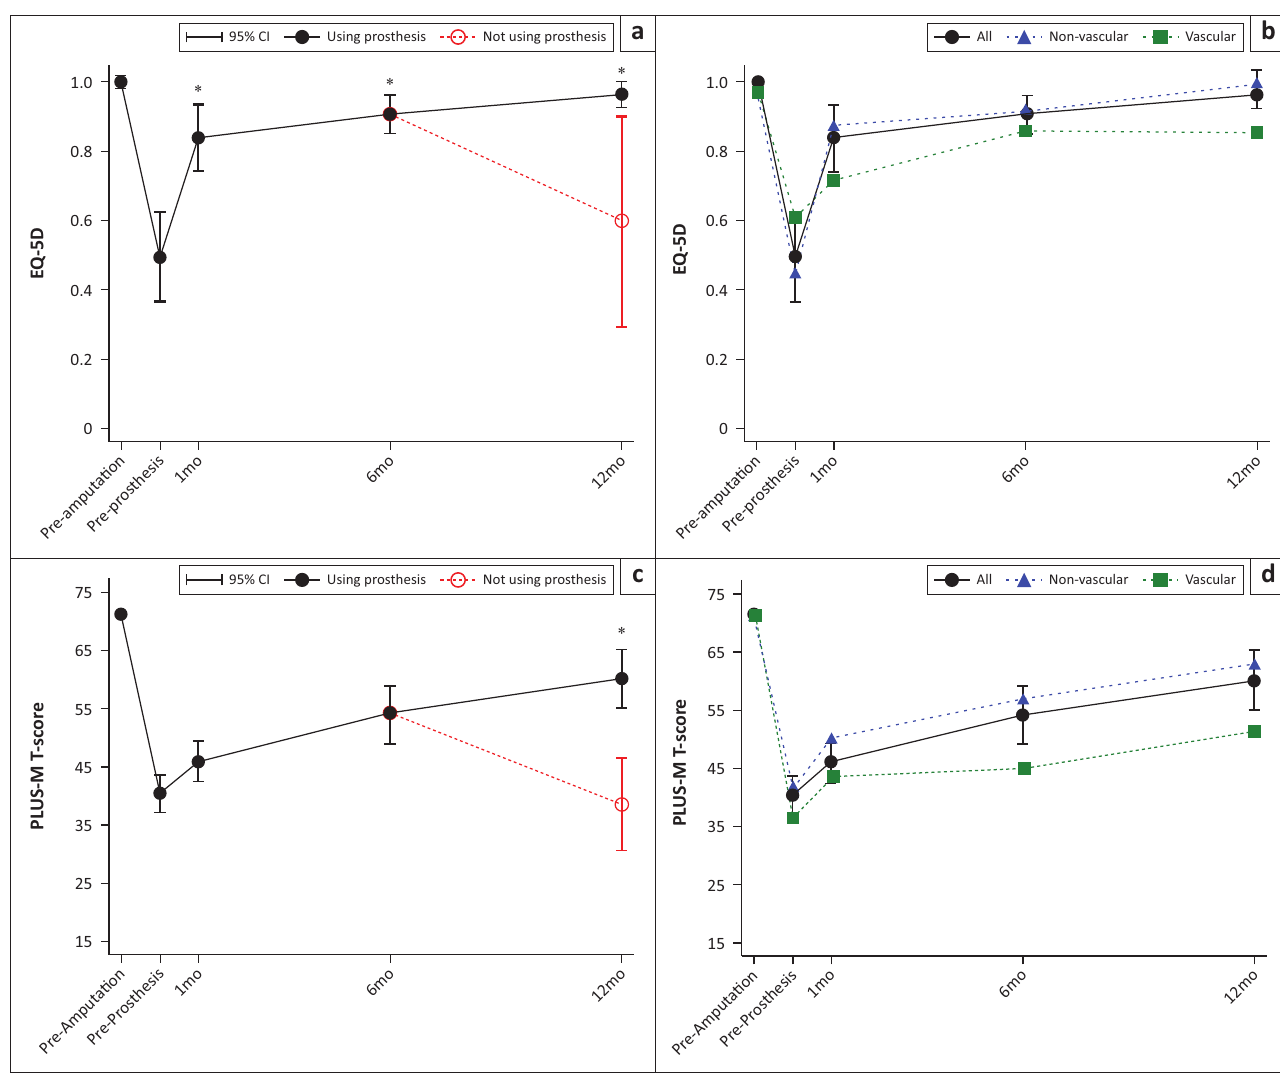
Note: Patient-reported outcome scores for patients reported to be using their prosthesis are shown in black, for patients reported not to be using their prosthesis are shown in red, for patients who underwent transfemoral amputation for trauma, tumour or infection are shown in blue and for patients who underwent transfemoral amputation for diabetes or vascular disease are shown in green. 95% confidence intervals (95 % CI) are reported. p -values were calculated using one-way repeated measures ANOVA and post hoc pairwise comparison with Bonferroni correction between pre-prosthesis and each subsequent follow-up timepoint, *, p < 0.05. FIGURE 3 : Patient-reported outcomes before amputation, at the casting visit before prosthesis fitting, 1, 6 and 12 months after prosthesis fitting: (a) EuroQol-5D (EQ-5D) health status scores before amputation (pre-amputation), at the casting visit before prosthesis fitting (pre-prosthesis) and at 1 month (1 mo), 6 months (6 mo) and 12 months (12 mo) follow-up after prosthesis fitting; (b) EQ-5D health status scores for patients separated by the reason for amputation at pre-amputation, pre-prosthesis, 1 mo, 6 mo and 12 mo for patients reported to be using their prosthesis; (c) Prosthetic Limb Users Survey of Mobility (PLUS-M) scores at pre-amputation, pre-prosthesis, 1 mo, 6 mo and 12 mo; (d) PLUS-M scores for patients separated by the reason for amputation at pre-amputation, pre-prosthesis, 1 mo, 6 mo, and, 12 mo for patients reported to be using their Functional outcomes The distance ambulated, in meters, during the 2MWT increased after prosthesis fitting (repeated-measures ANOVA, p < 0.001), trending higher than pre-prosthesis baseline (68.26) at 6 months after prosthesis fitting (84.87, p = 0.059; Figure 4a, Table 1-A1). Distance ambulated by the non-vascular subgroup was higher than the vascular subgroup at 1 month (66.81, p = 0.018) and 6 months (91.47, p = 0.024) after prosthesis fitting (33.25 and 50.20, respectively) (Figure 4b, Table 1-A1). Physiologic Cost Index was never significantly different from pre-prosthesis baseline (repeated-measures ANOVA p = 0.0623; Figure 4c, Table 1-A1). Physiologic Cost Index was significantly lower in the non-vascular subgroup than